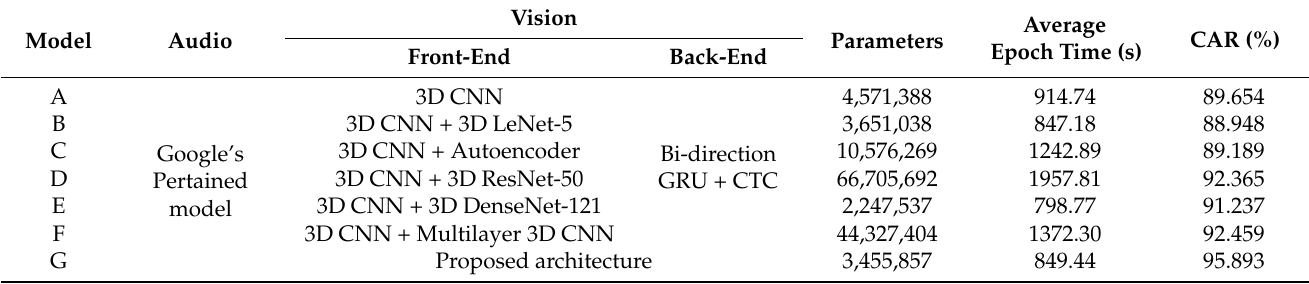
Table 1. Performance, number of parameters, and training time of proposed model compared to those of the baseline and other models.